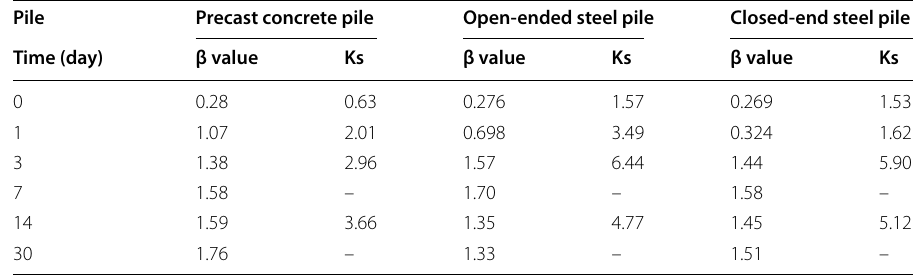
Table 3 β values estimated from measured shaft